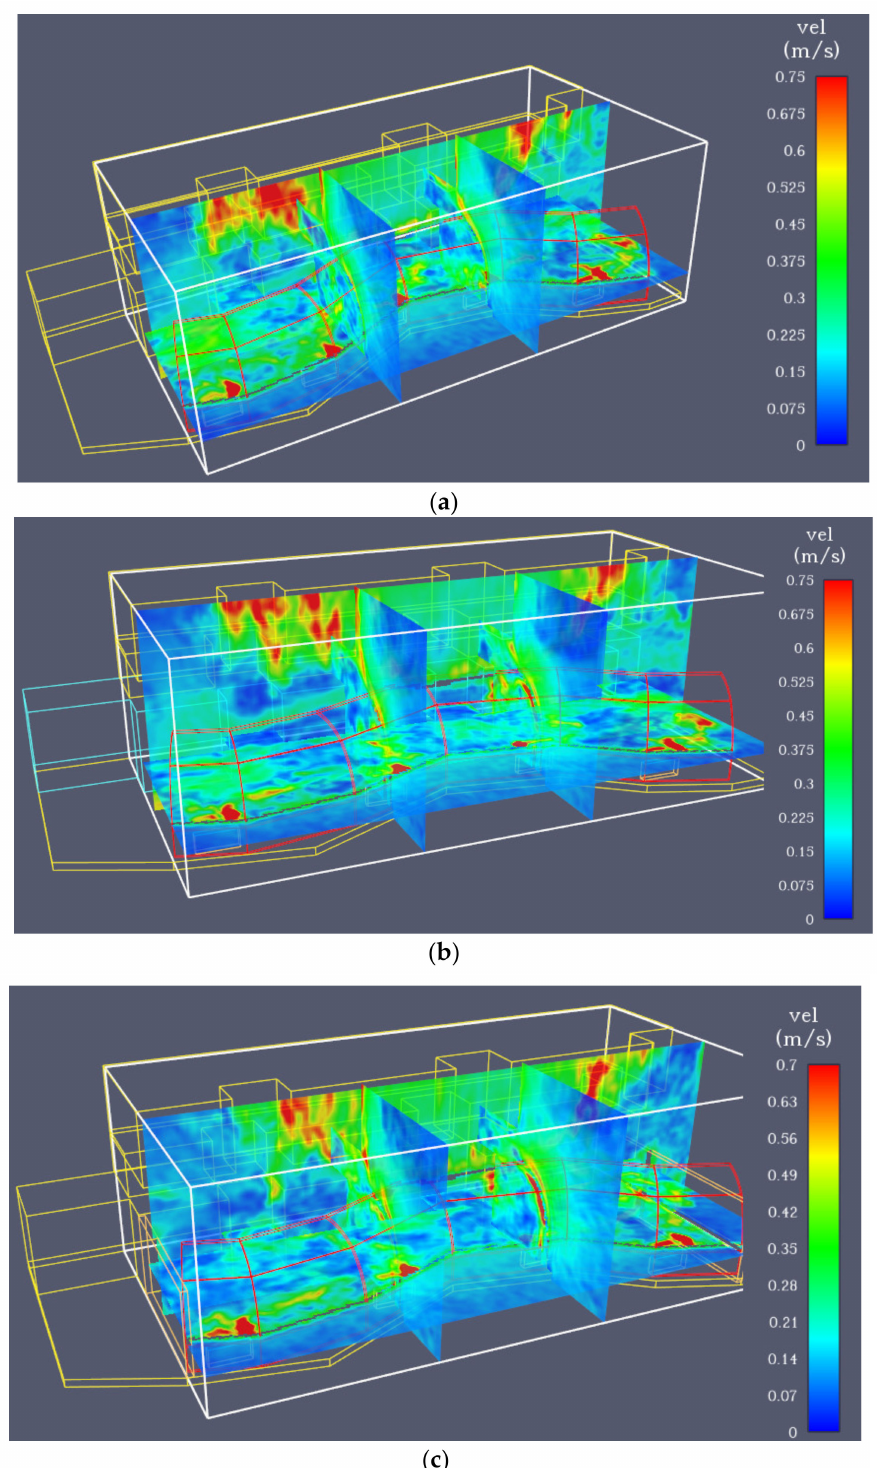
Figure 17. Air velocity fields at t = 500 s for: ( a ) A configuration; ( b ) B configuration; and ( c ) C